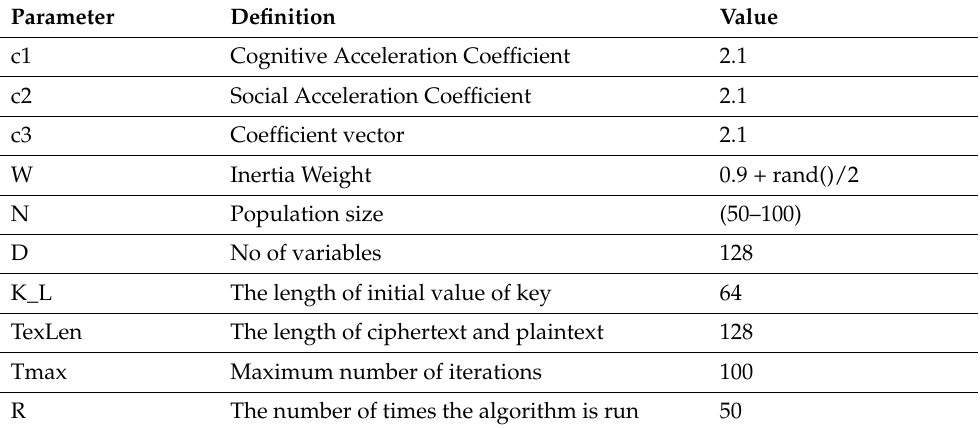
Table 4. The BHPSOEO parameters to attack the RC4 cipher with Textlen, 128